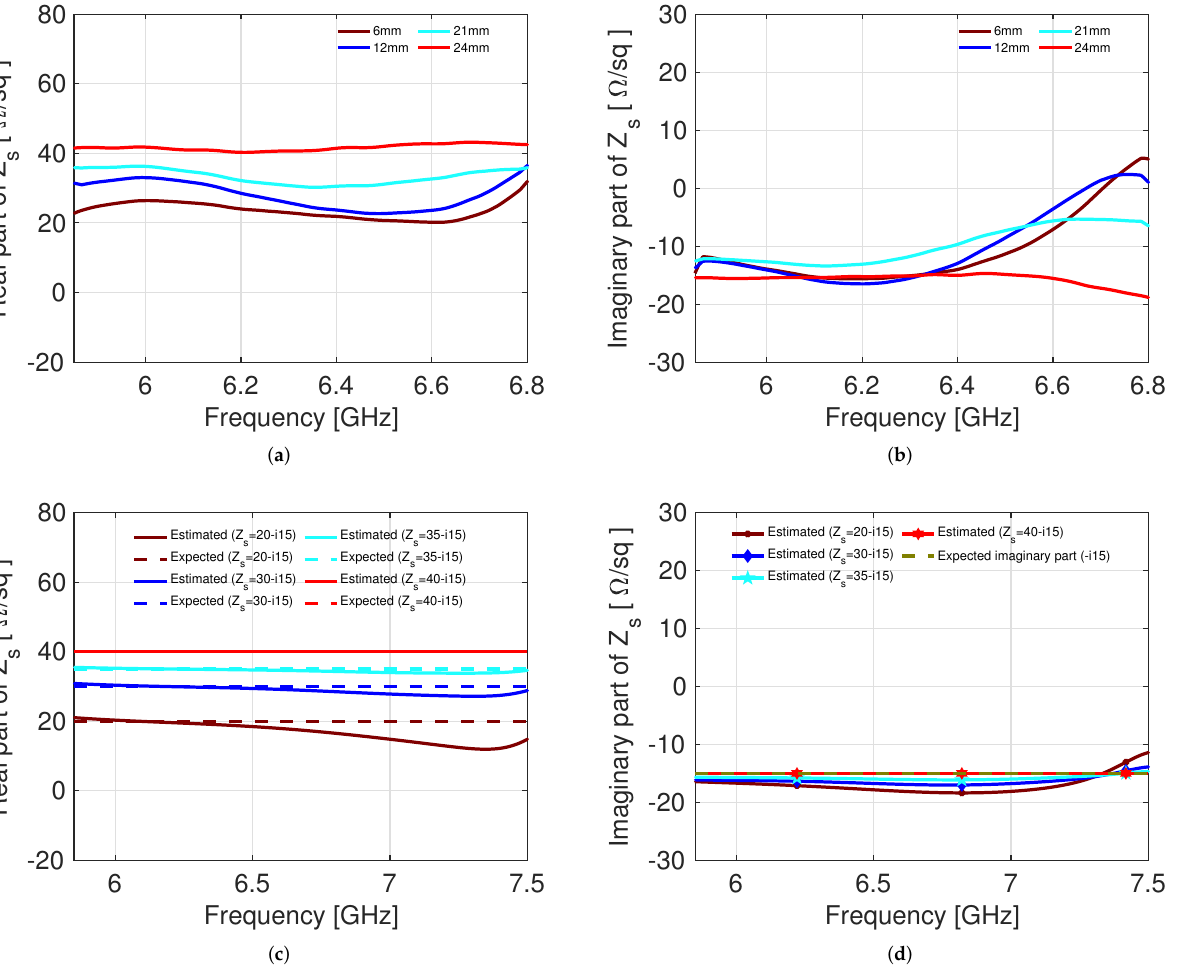
Figure 7. Comparison between experimental measurements and numerical simulations: ( a ) real part of the surface impedance obtained from the experimental measurements; ( b ) imaginary part of the surface impedance obtained from the experimental measurements; ( c ) real part of the surface impedance obtained from the CST simulations; ( d ) imaginary part of the surface impedance obtained from the CST